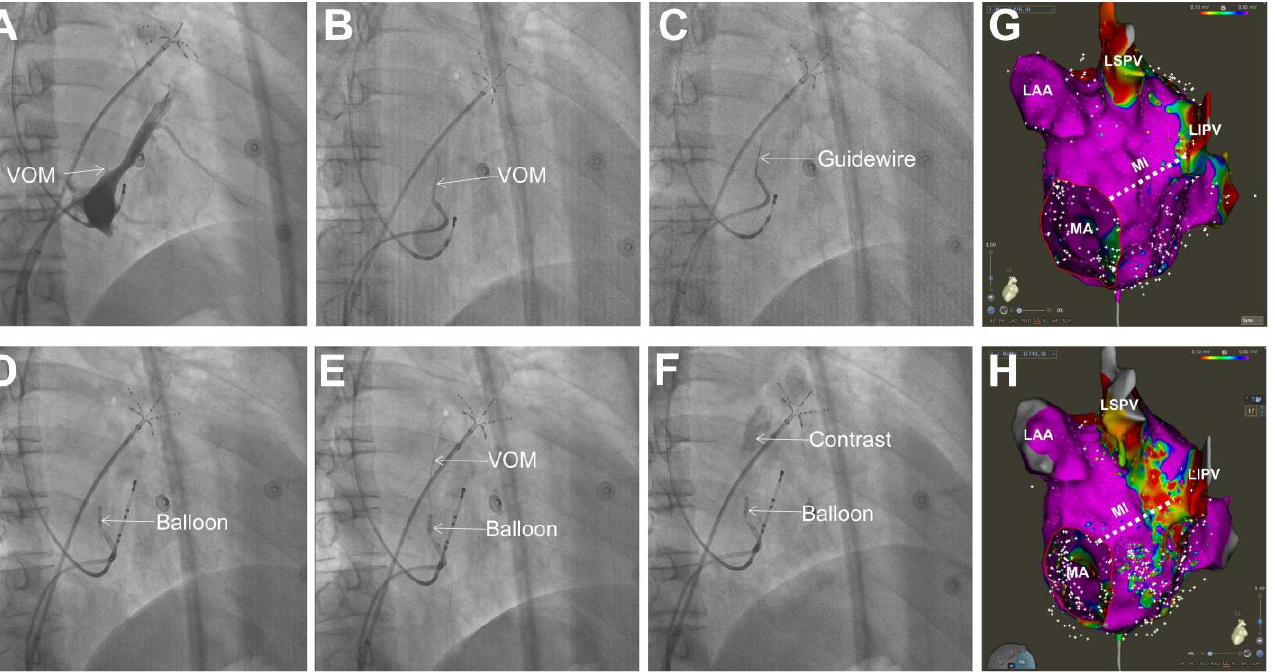
Figure 4. Fluoroscopic images in RAO view showing the procedural steps of VOM ethanol infusion. ( A ) Coronary sinus venography showing the presence of VOM. ( B ) Selective VOM venography. ( C ) Guidewire advanced into the VOM. ( D ) Balloon advanced into the VOM and inflated. ( E )